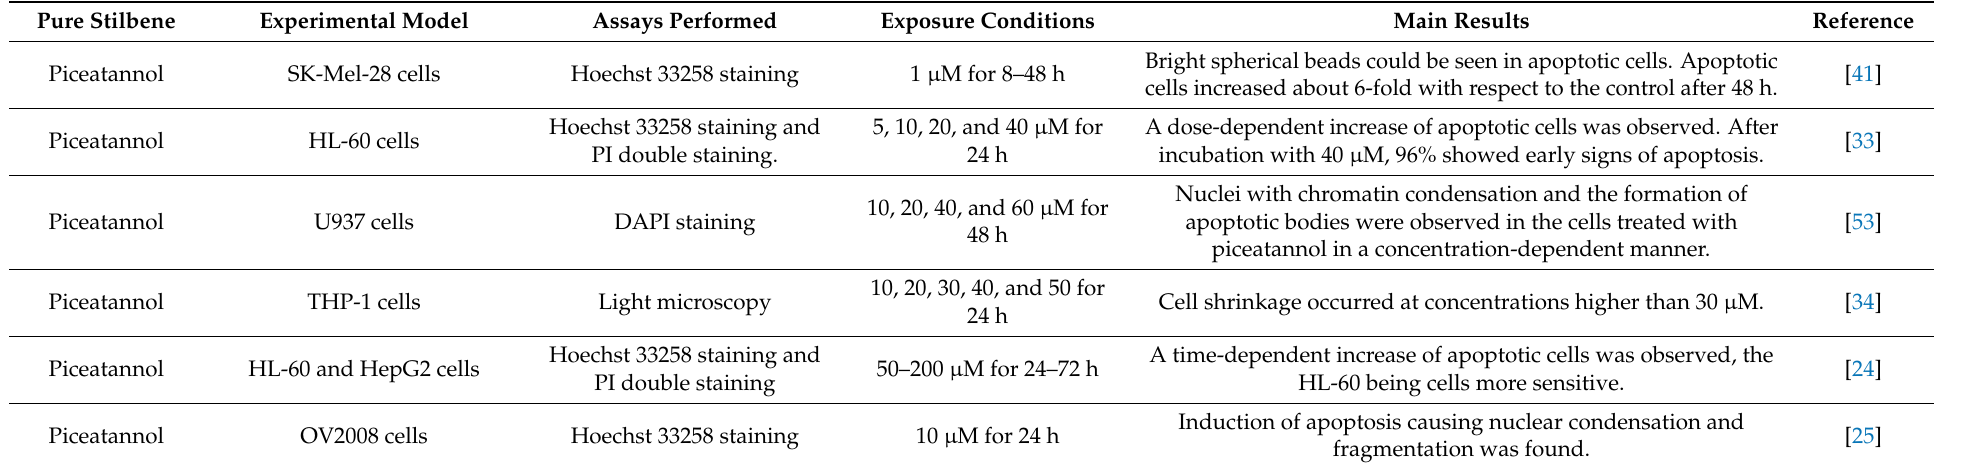
Table 2. In vitro morphological studies performed with